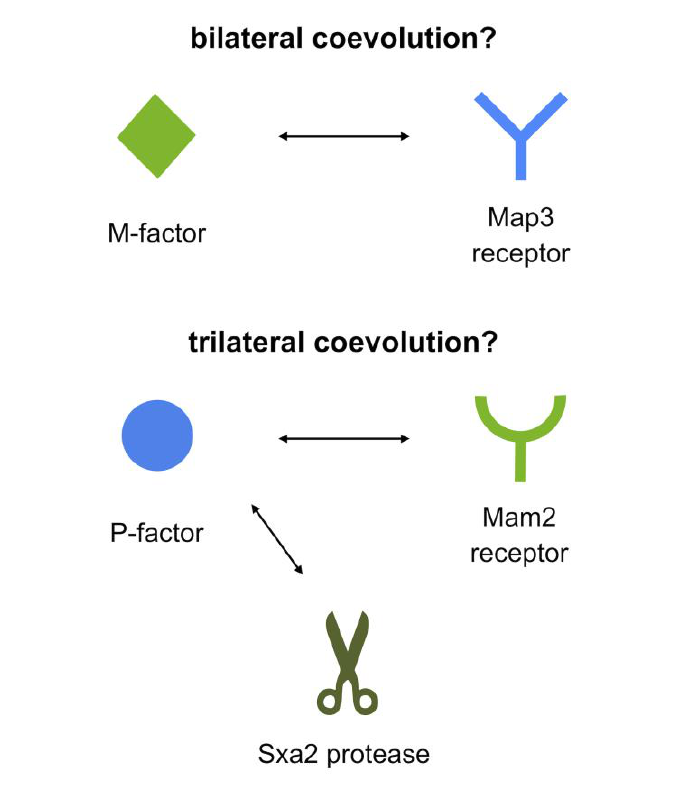
FIGURE 2: Model of the asymmetric diversification of two mating pheromones in terms of specific proteases. M-factor is recognized by the Map3 receptor, leading to ‘bilateral’ coevolution . By contrast, P-factor is recog- nized by both the Mam2 receptor and the Sxa2 prote- ase, perhaps leading to ‘ trilateral ’ coevolution coupled with P-factor divergence, thereby facilitating more rapid diversification of P-factor relative to